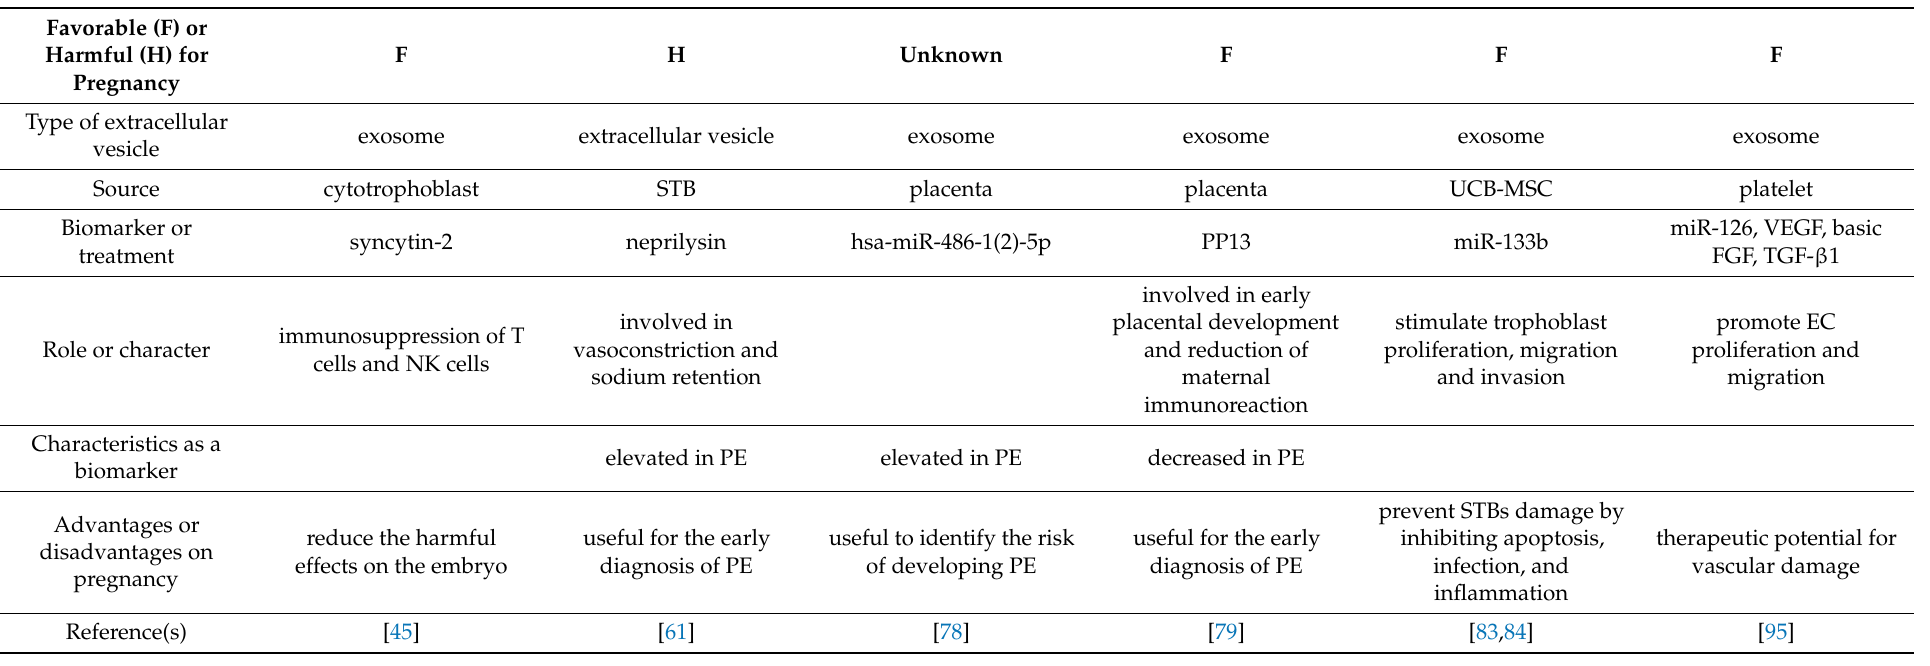
Table 1. Exosomes as potential biomarkers for the diagnosis and treatment of preeclampsia